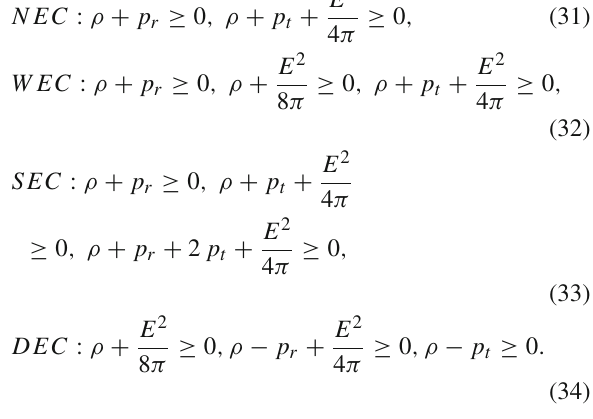
Fig. 4 Variation of (i) q ( r ) (upper panel) and (ii) E 2 ( r )/ 8 π (lower panel) as a function of the radial coordinate r / R for the strange star LMC X − 4